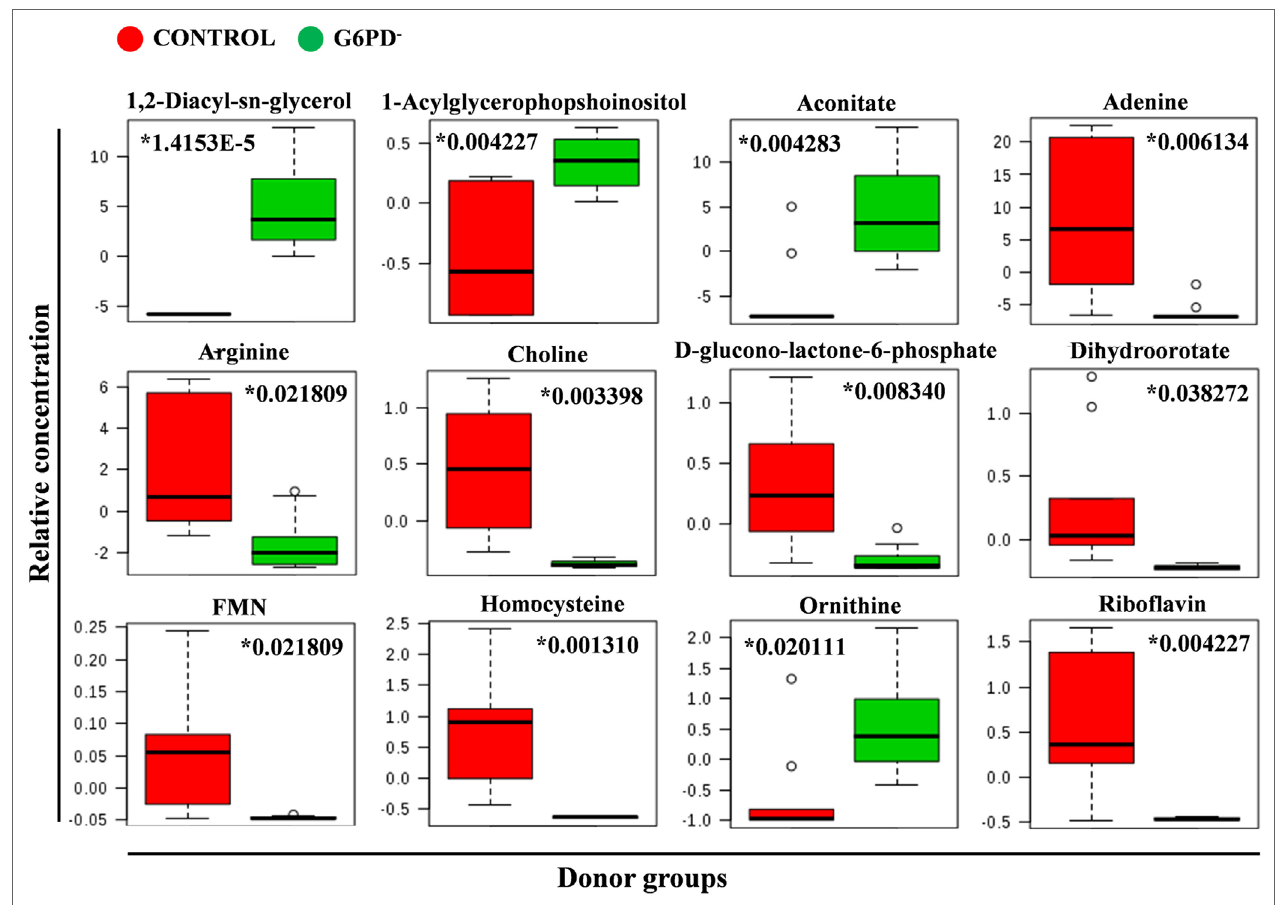
FigUre 5 | Quantitative assessment of selected metabolites. Box and whisker plots for selected significantly altered metabolites in G6PD − FFP compared with control (units in normalized and scaled concentrations). The x -axis shows the specific metabolite and the y -axis is the relative concentration. Medians are indicated by horizontal lines within each box. Outliers are plotted as individual points. Numbers with asterisks indicate adjusted p